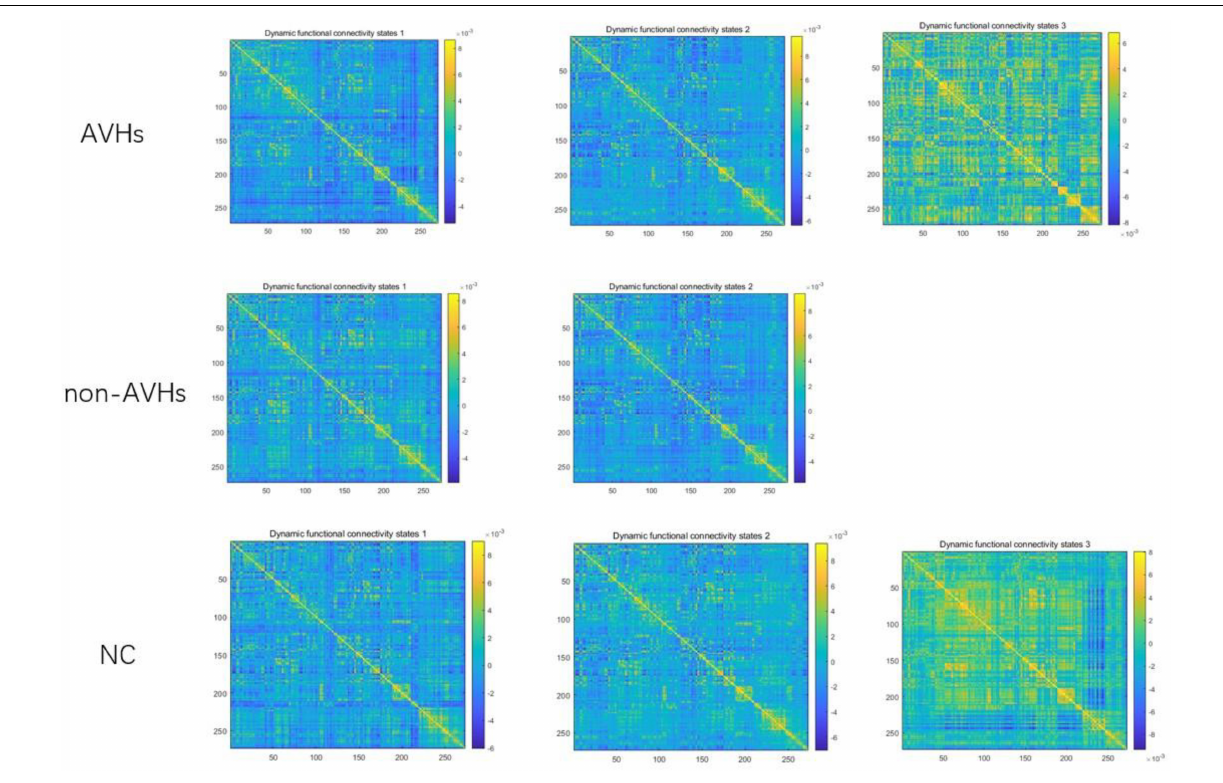
functional connections was significantly increased in the AVHs group under the two preprocessing strategies. In a cluster analysis of the two groups based on the dynamic nature of functional connectivity, schizophrenia patients with AVHs shifted between